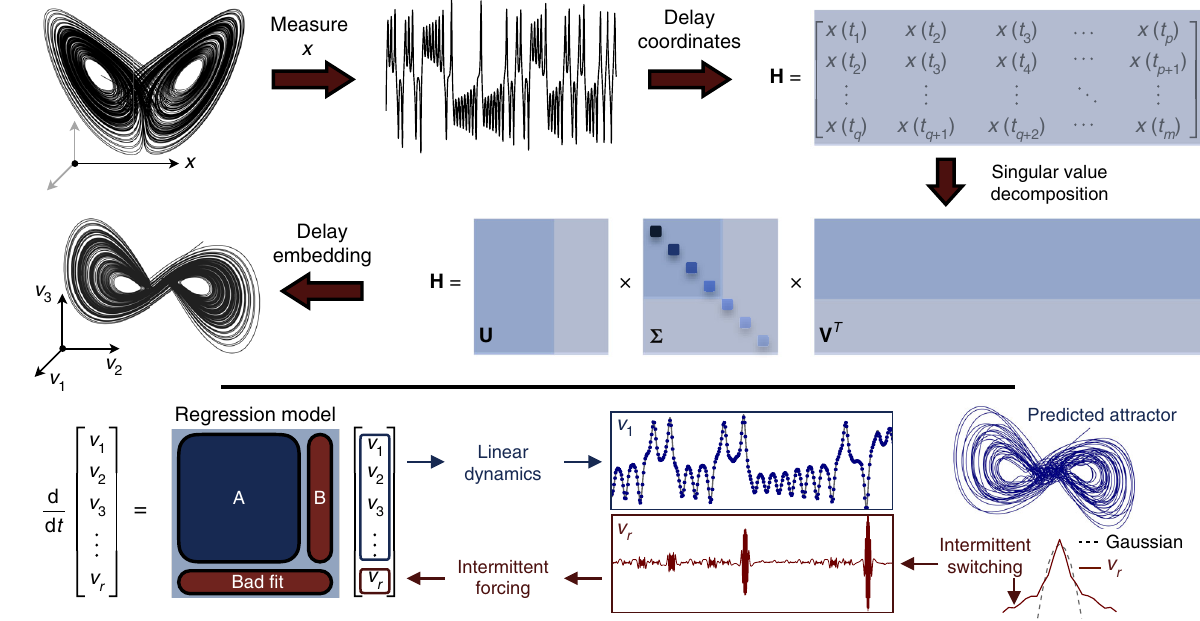
Fig. 1 Decomposition of chaos into a linear dynamical system with forcing. A time series x ( t ) is stacked into a Hankel matrix H . The SVD of H yields a hierarchy of eigen time series that produce a delay-embedded attractor. A best- fi t linear regression model is obtained on the delay coordinates v ; the linear fi t for the fi rst r − 1 variables is excellent, but the last coordinate v r is not well-modeled as linear. Instead, v r ( t ) is a stochastic input that forces the fi rst r − 1 variables. The rare events in the forcing correspond to lobe switching in the chaotic dynamics. This architecture is called the Hankel